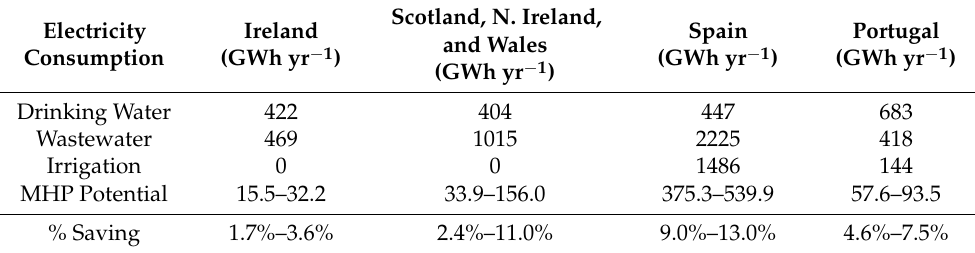
Table 9. Electricity consumption estimates across the six countries assessed compared against the potential energy recoverable using MHP for drinking, wastewater, and irrigation